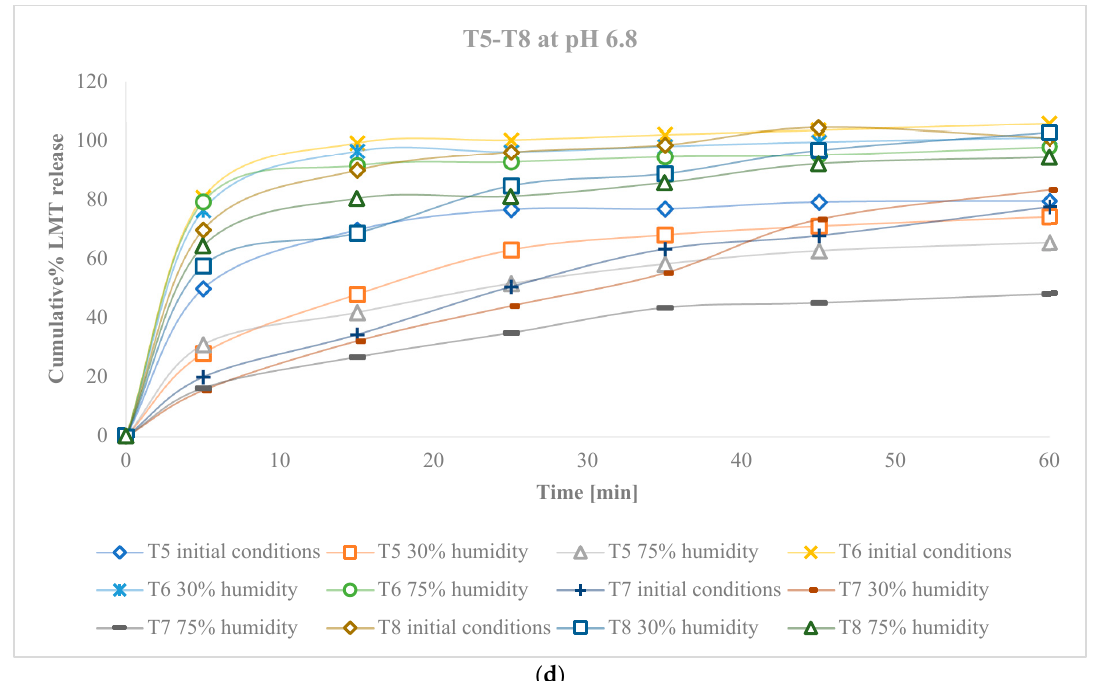
Figure 7. Dissolution profiles of LMT tablet formulations ( a ) T1–T4 and ( b ) T5–T8 at pH 1.2; ( c ) T1–T4 and ( d ) T5–T8 at pH 6.8 and for initial conditions, after conditions of reduced and increased humidity.